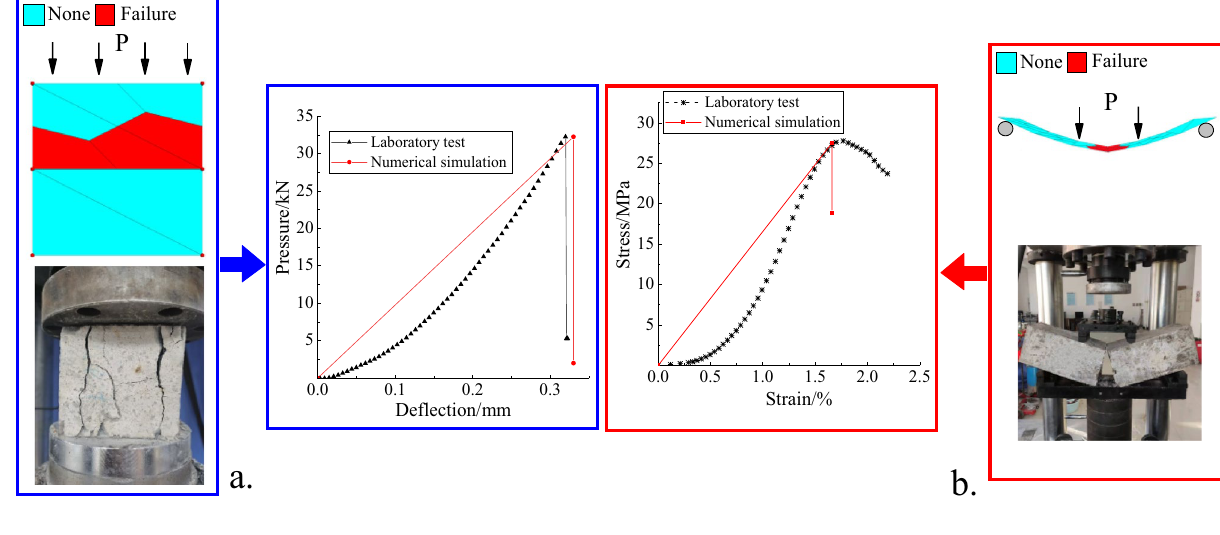
Figure 4. Comparison of the concrete test